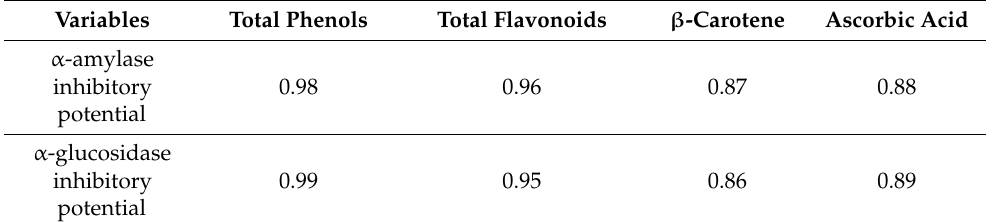
Table 5. Correlation matrix between different variables and bioactive constituents (dried T. officinale